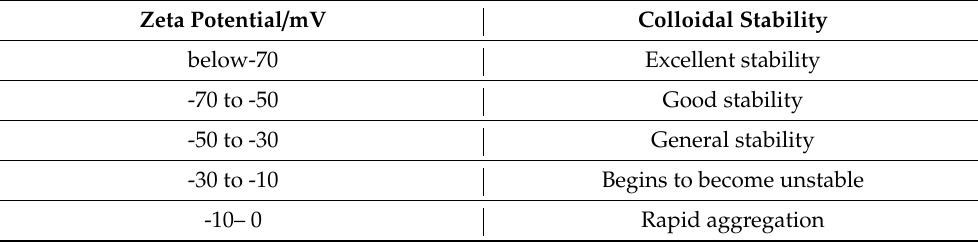
Table 1. The relationship between system stability and Zeta